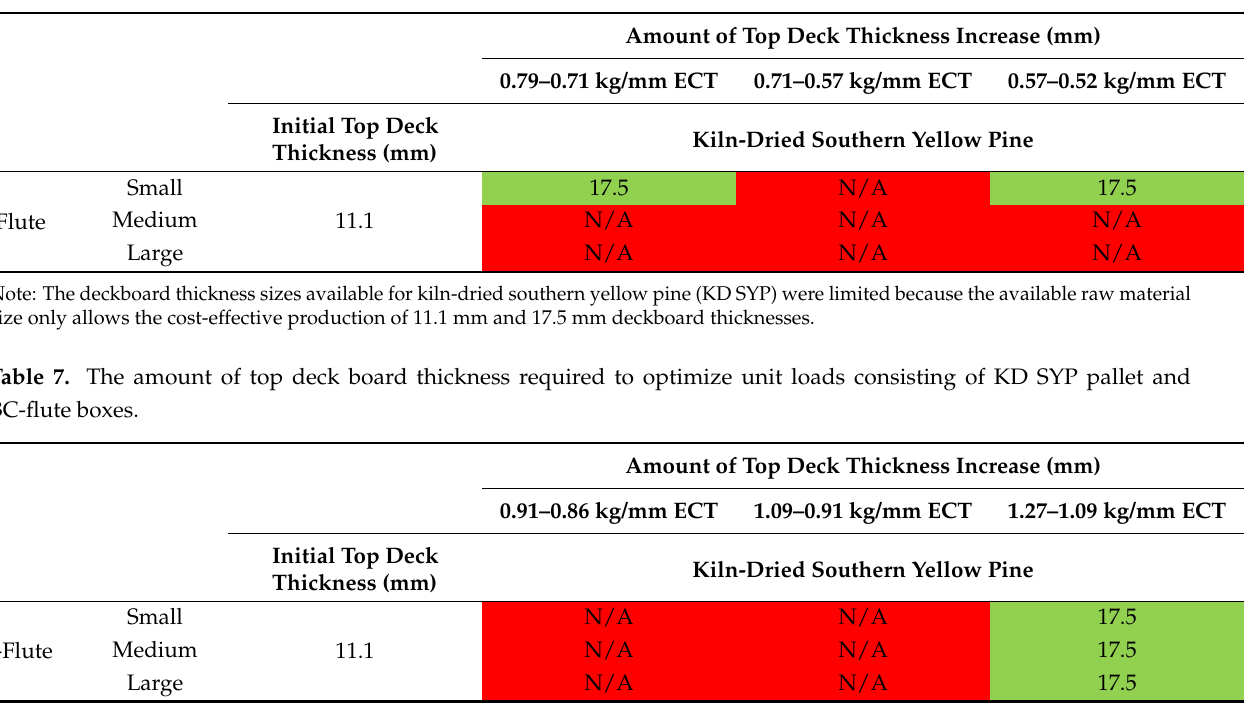
Table 6. The amount of top deck board thickness required to optimize unit loads consisting of KD SYP pallet and C-flute boxes.